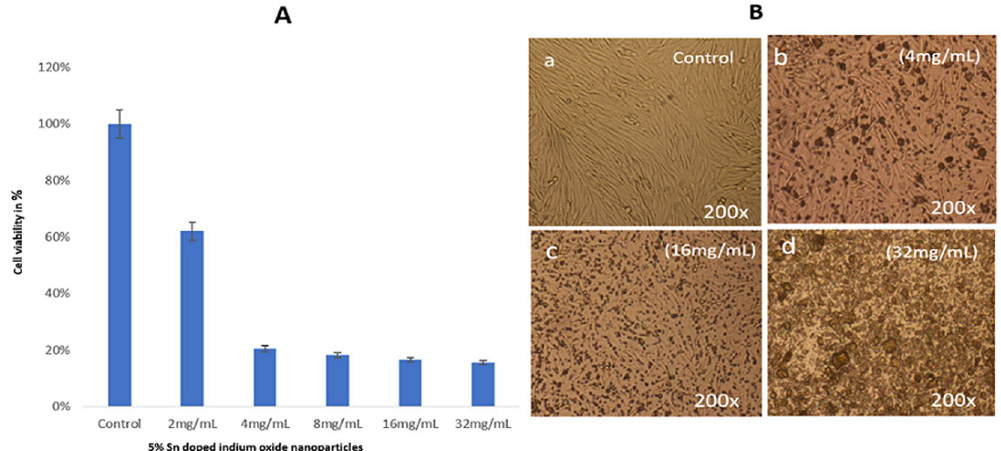
Figure 6. ( A ) MTT Assay ( B ) Cell morphology of HCT-116 cells after treatment with different concentrations of 5% Sn doped indium oxide at 200 ×